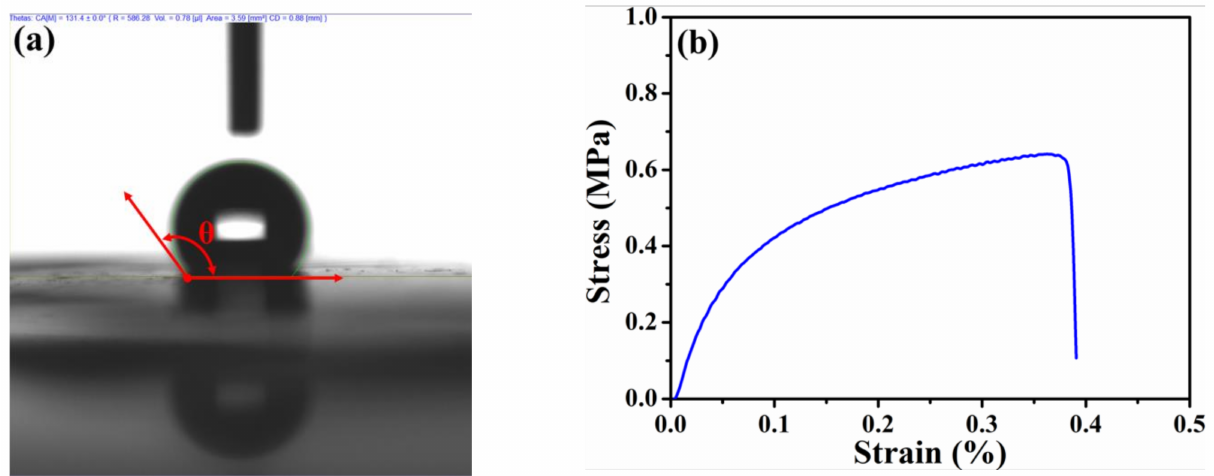
Figure 2. The deionized (DI) water contact angle ( a ) and stress–strain curve ( b ) of the high-mass loading hierarchically porous activated carbon